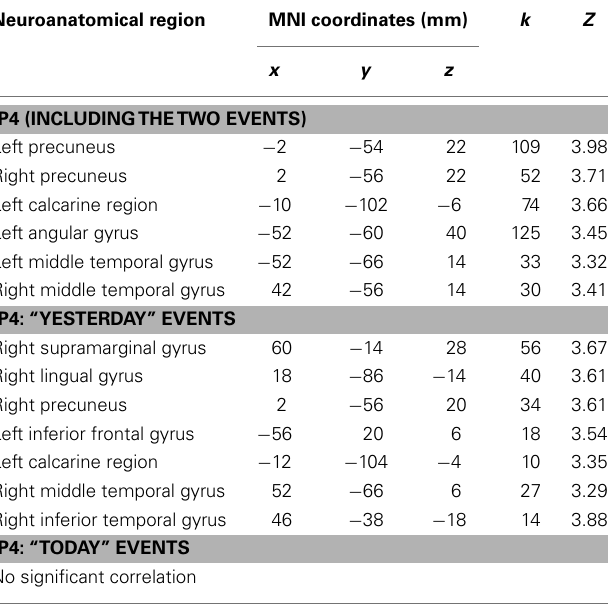
Table 2 | Significant correlations between brain glucose consumption and the total recall score for the recent period (P4).